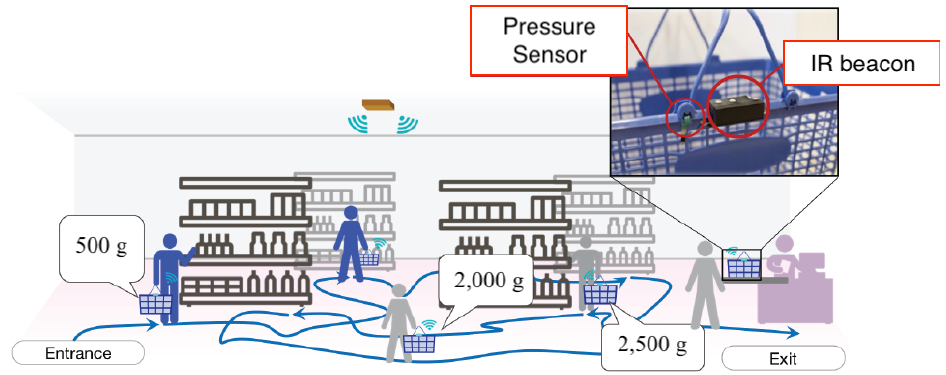
Figure 10. Measuring the interaction between service actors (customer and merchandise) while customers moved in stores